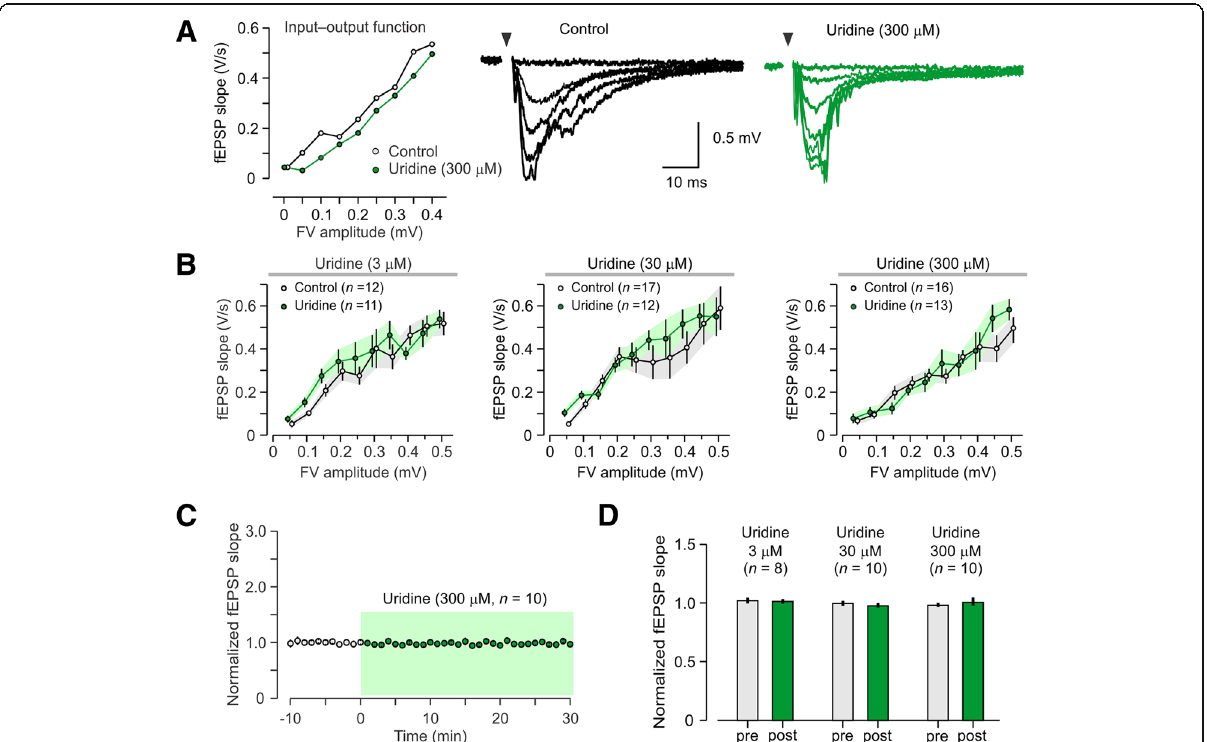
Fig. 1 Null effect of uridine on basal synaptic transmission. a Left, representative input-output (I-O) experiments for uridine (300 μ M) and control; with the amplitude of the fiber volley (FV) as the independent variable and the slope of the fEPSP as the dependent variable. Right, sample overlaid traces from single I-O experiments. Electrical stimulation artifacts have been removed and are marked by arrowheads. b Plots of I-O responses (mean ± SEM) indicate that basal synaptic transmission is not affected by any of the uridine concentrations tested. c Representative experiment showing that the fEPSP slope remains unchanged when uridine (300 μ M) is added to the brain slice placed in the recording chamber. d Normalized fEPSP slope (mean ± SEM) showing that uridine (3 μ M, 30 μ M, and 300 μ M) does not cause changes in field synaptic potentials, when measured 30 min